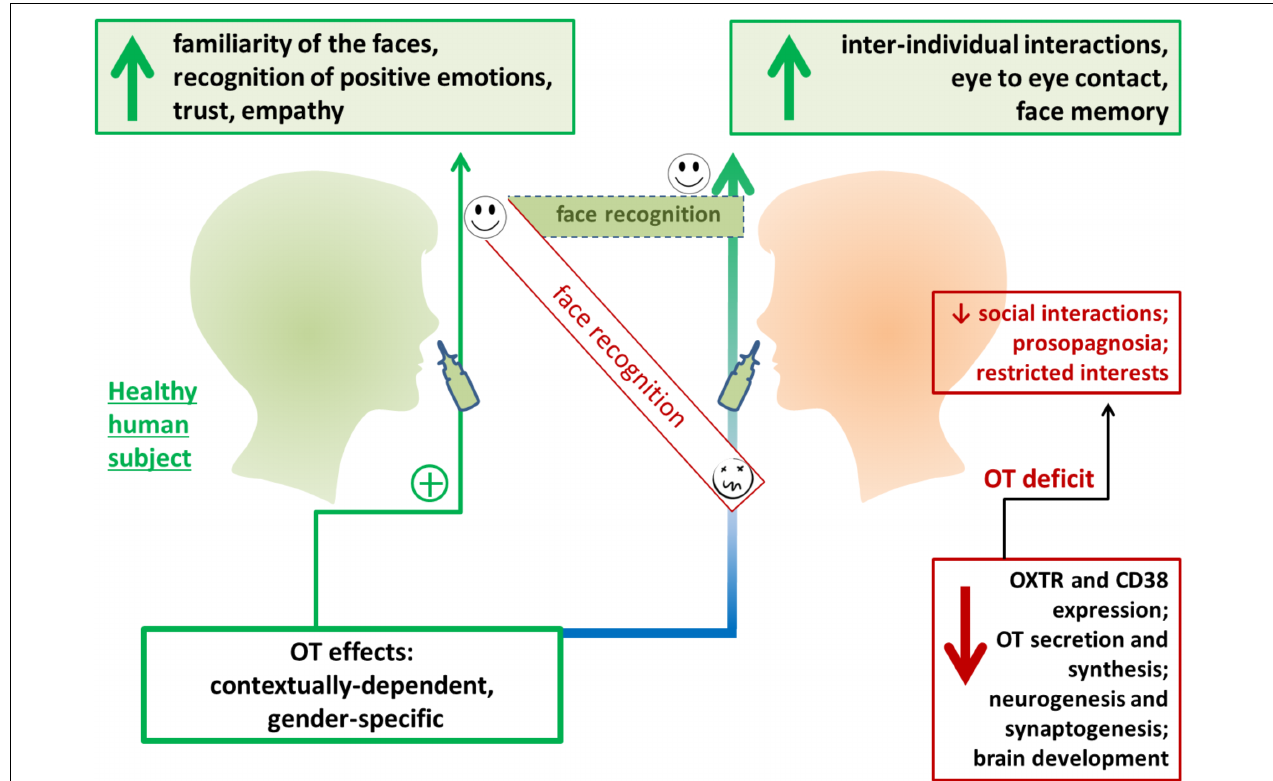
FIGURE 2 | Exogenous oxytocin (OT) facilities face recognition in humans. Intranasal OT administration has been found to improve perception of facial expressions and affect trust in human participants. OT administration has been found to improve inter-individual interactions and communication in individuals with social behavior deficits. OXTR, oxytocin